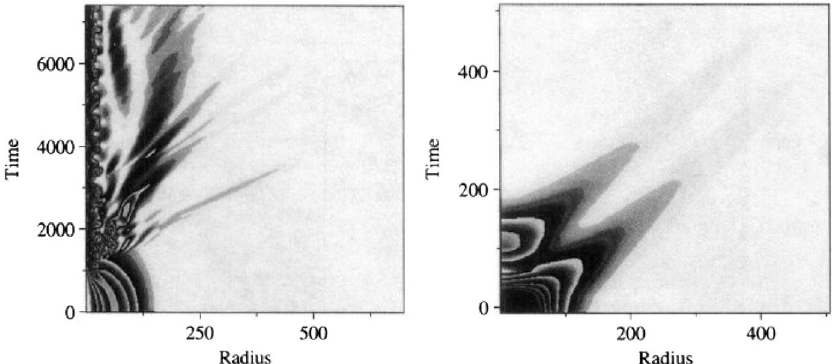
Fig. 18 The evolution of r 2 q (where q is the energy density of the complex scalar fi eld) with massive fi eld (left) and massless (right). In the massive case, much of the scalar fi eld collapses and a perturbed boson star is formed at the center, settling down by gravitational cooling. In the massless case, the scalar fi eld bounces through the origin and then disperses without forming any compact object. Reproduced with permission from Seidel and Suen (1994), copyright by